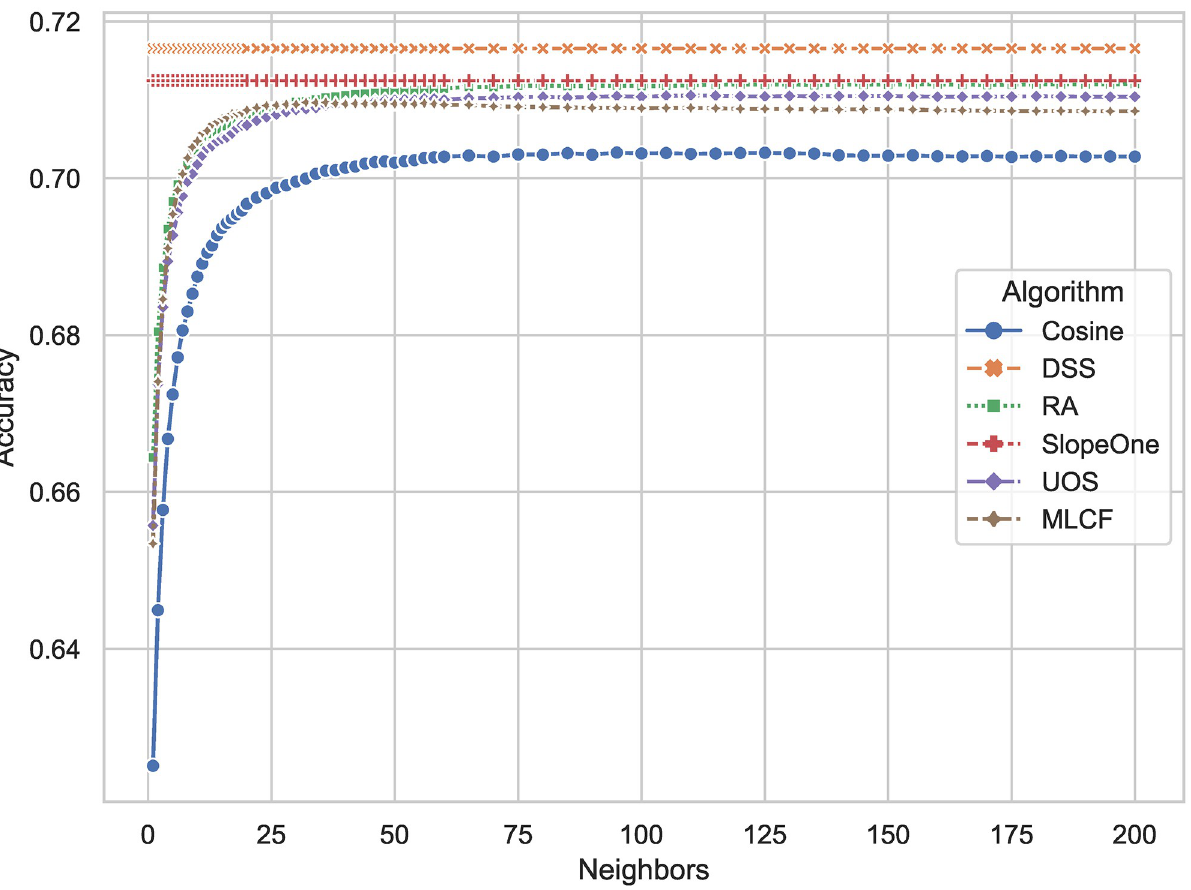
Fig 11. Accuracy of different algorithms. The larger the result, the more accurate the algorithm is in predicting user preferences.